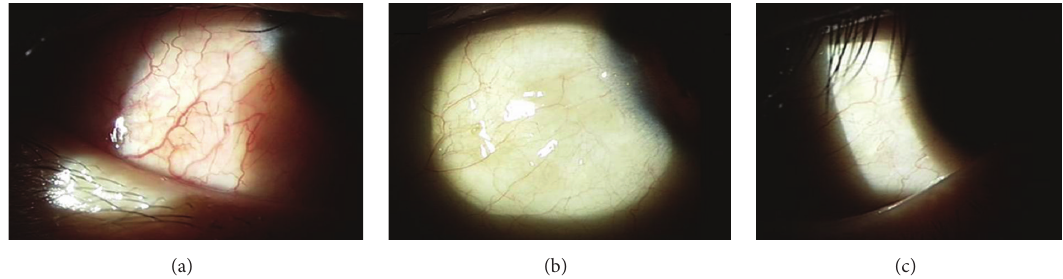
Figure 3: Representative anterior segment photography of a 42-year-old man who underwent 23-gauge vitrectomy with air tamponade due to diabetic vitreous hemorrhage. (a) Mild chemosis was observed at the inferotemporal quadrant with mild conjunctival injection in anterior segment photographs on postoperative day 1. (b) Conjunctival chemosis and injection disappeared at 1 week after operation. (c) Clear conjunctiva was observed at 1 month after operation.